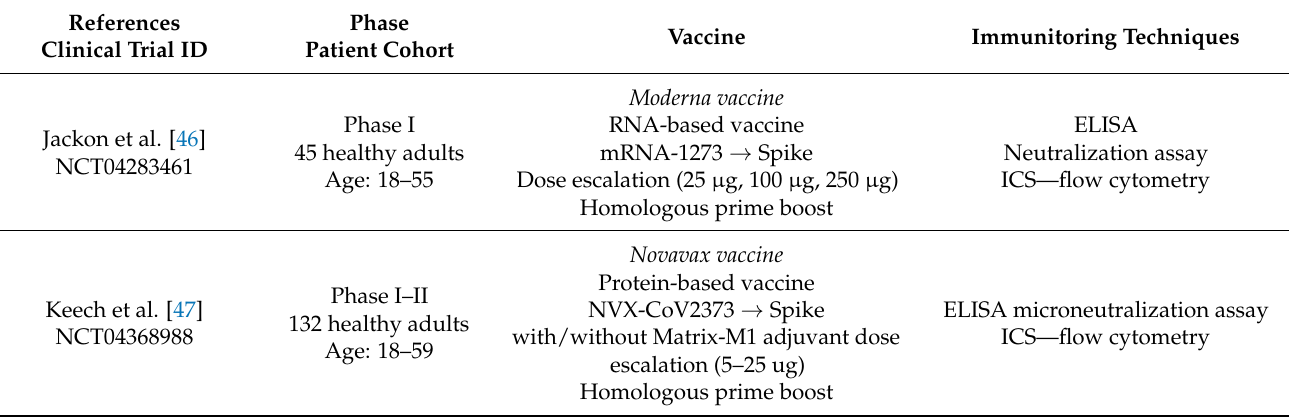
Table 2. Overview of the immunomonitoring approaches used in SARS-CoV-2 vaccine clinical